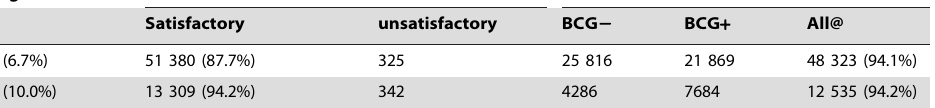
Excluded from testing